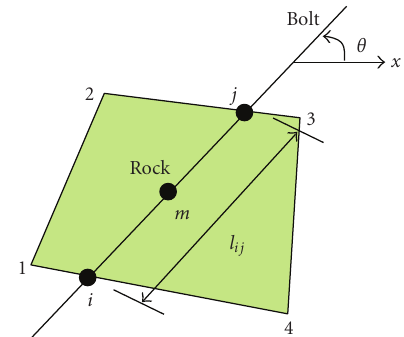
Figure 5: Discretization rock and bolt interaction